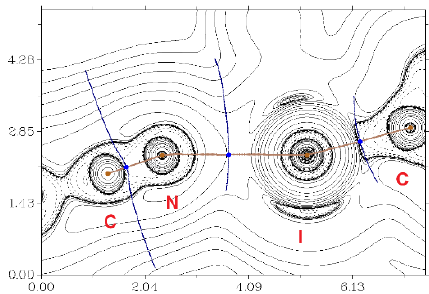
* Numeration of atoms in the model structure corresponds to their ordering in Table S1, Supporting Information. ** The shortest van der Waals radii for I, S, N and H atoms are 1.98, 1.80, 1.55 and 1.20 Å , respectively [43]. a E int = 0.68 (−V( r )) (correlation developed exclusively for noncovalent interactions involving iodine atoms) [48]. b E int = 0.67 G( r ) (correlation developed exclusively for noncovalent interactions involving iodine atoms) [48].